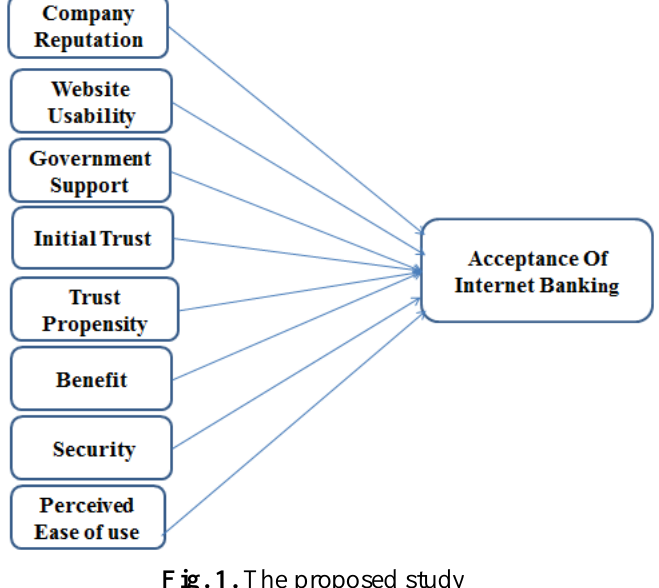
Fig. 1. The proposed study